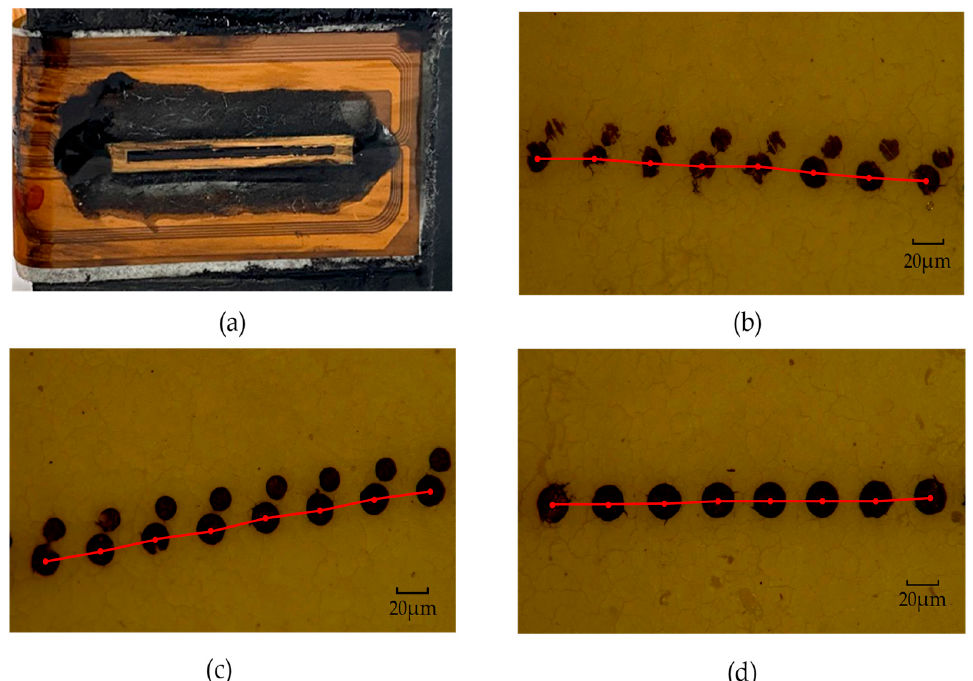
Figure 14. The ink marks lines of inkjet printing under the different driving voltages as observed under an optical microscope (made by Shenzhen Aosvi Optical Instrument Co., Ltd., Shenzhen, China, and with ink produced by the company of Asdun, Shenzhen, China). ( a ) When the driving voltage was 6V, the inkjet chip could not work normally, and an ink blockage occurred at this time. ( b ) The printing path of the inkjet chip when the driving voltage was 8 V. ( c ) The printing path of inkjet chip when the driving voltage was 10 V. ( d ) The printing path of inkjet chip when the driving voltage was 12 V.